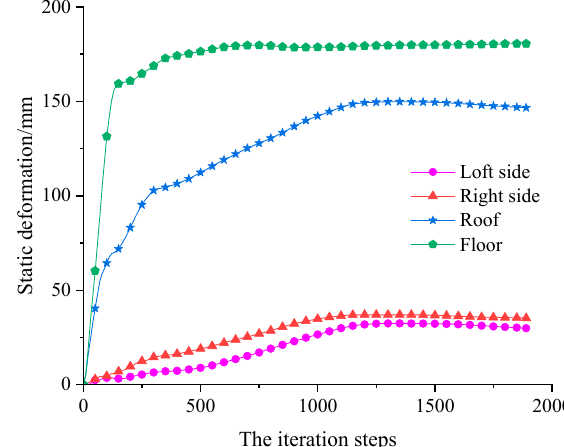
Figure 12. Deformation of roadway under static load.